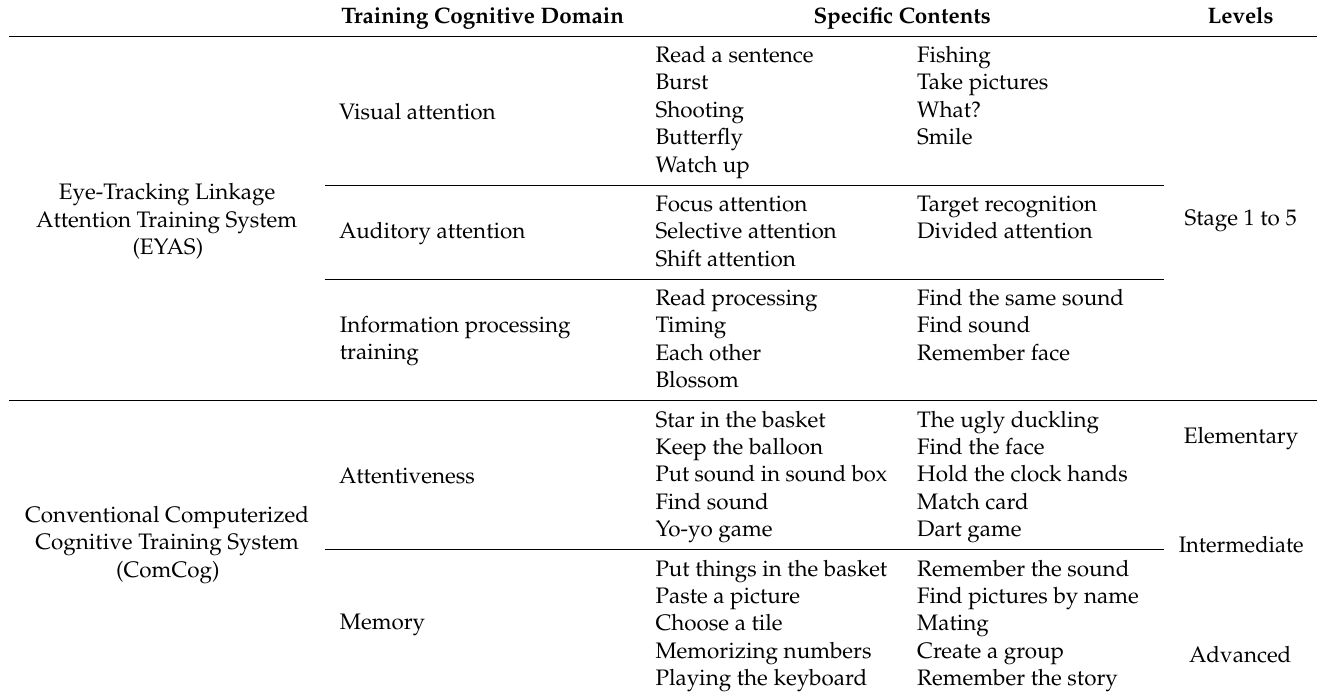
Table 1. Information on the training cognitive domain and specific contents of cognitive rehabilitation